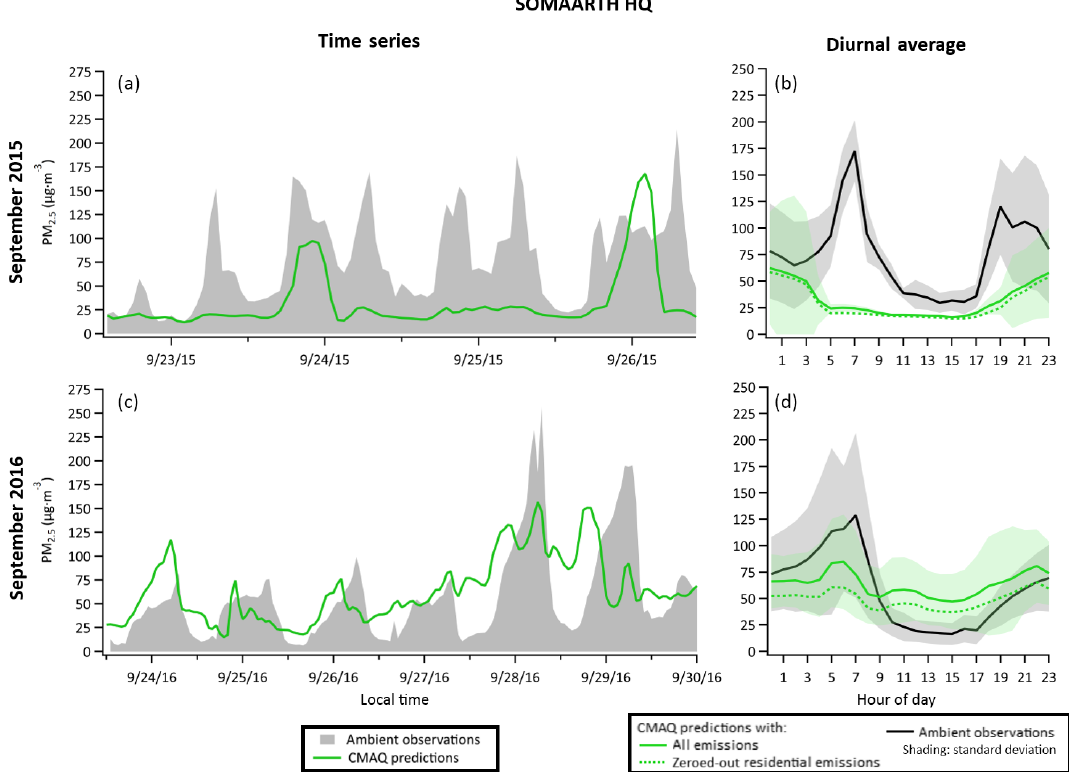
Figure 7. Measured and predicted PM 2 . 5 (a, c) and average diurnal cycle (b, d) at SOMAARTH HQ for 20–31 December 2015 (a, b) and 20–30 September 2016 (c, d) . Here the green lines correspond to CMAQ predictions of the “total” (solid) and “nonresidential” (dotted) sim- ulations. The solid black line represents ambient observations. Standard deviations of the diurnal profiles for observations and predictions are indicated by gray and green colored shading, respectively. Diurnal profiles were averaged over simulation durations (Table 7). Computations were carried out at 4km